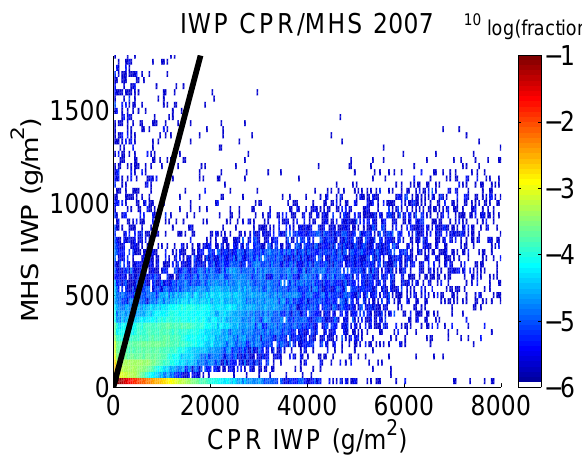
Fig. 7. Two-dimensional histogram of CloudSat CPR Ice Water Path (averaged over an AMSU pixel) and NOAA NESDIS MSPPS IWP, for all collocations in the year 2007. The figure is similar to a scatter plot, but it shows the density of points rather than the actual points. Only measurements where either value is nonzero are shown. The black line shows the ideal case. The colour scale is logarithmic. See text for a discussion.